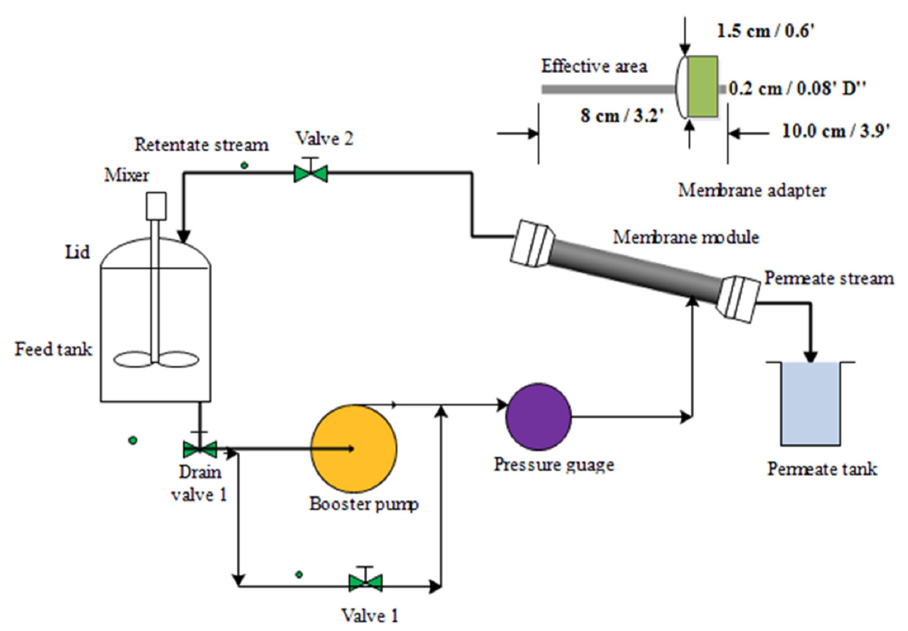
Figure 2. Schematic representation of cross-flow ultrafiltration system of a modified membrane with membrane adapter.